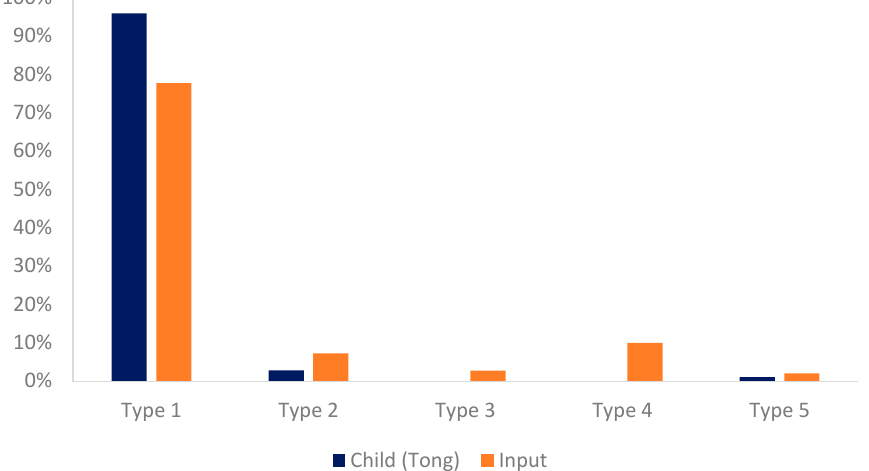
Figure 4. Proportions of the semantic representations of 打 d ǎ in Tong and his input. Type 1: Physical action focusing on hand contact; Type 2: hand action (mostly with instrument); Type 3: physical action with physical contact unspecified; Type 4: metaphorical uses (hand action traceable); Type 5: metaphorical uses (hand action untraceable).